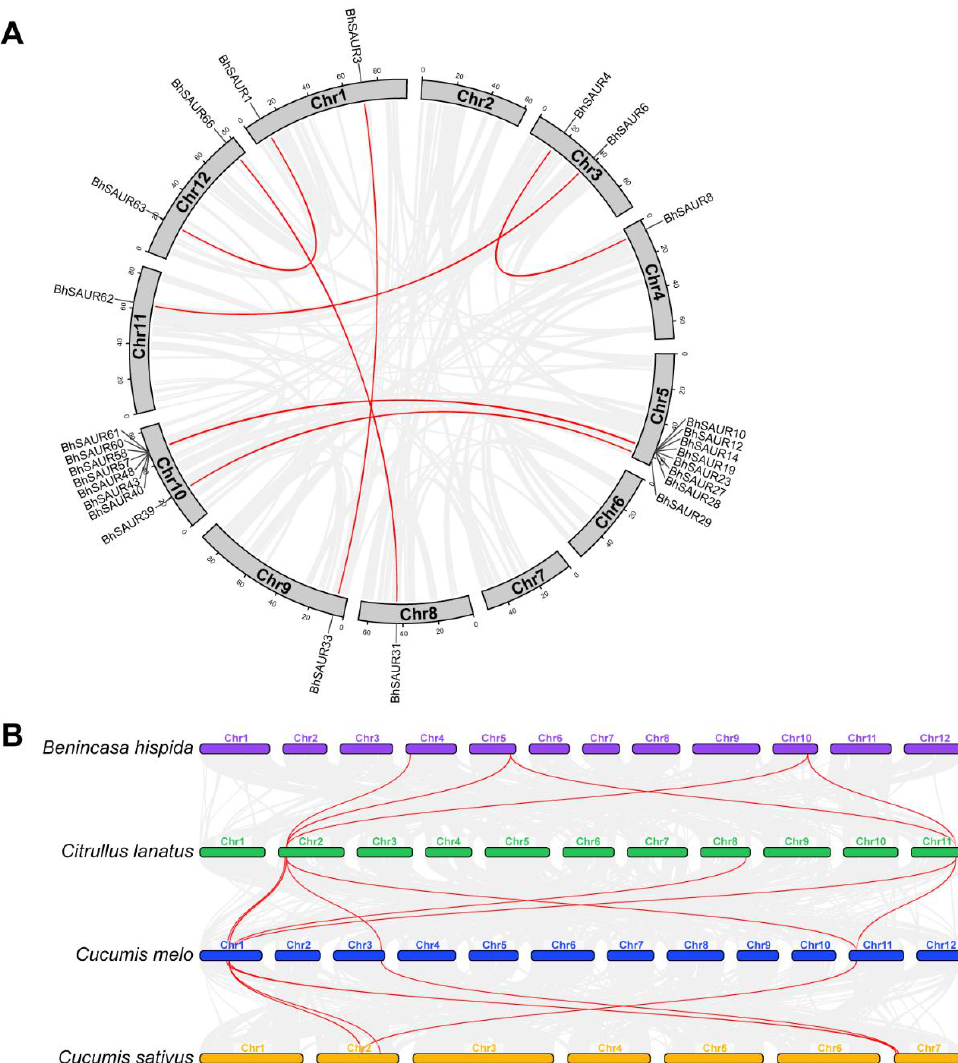
Figure 2. Synteny analysis of the SAUR genes. ( A ) Synteny analysis of the SAUR genes in wax gourds. Grey lines display the collinear gene pairs in the wax gourd genome. Red lines indicate the collinear BhSAUR gene pairs; ( B ) gene synteny analysis across the wax gourd ( Benincasa hispida ), watermelon ( Citrullus lanatus ), melon ( Cucumis melo ), and cucumber ( Cucumis sativus ). Grey lines display the collinear gene pairs across four cucurbit crop genomes. Red lines indicate the collinear SAUR gene pairs in the gene clusters.